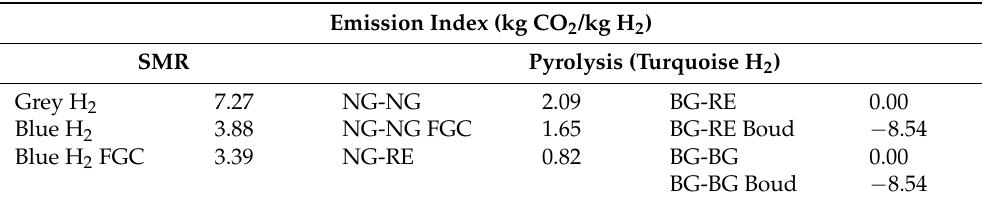
Table 5. The emission index for grey, blue, and turquoise hydrogen (Excluding hydrogen purifying processes such as